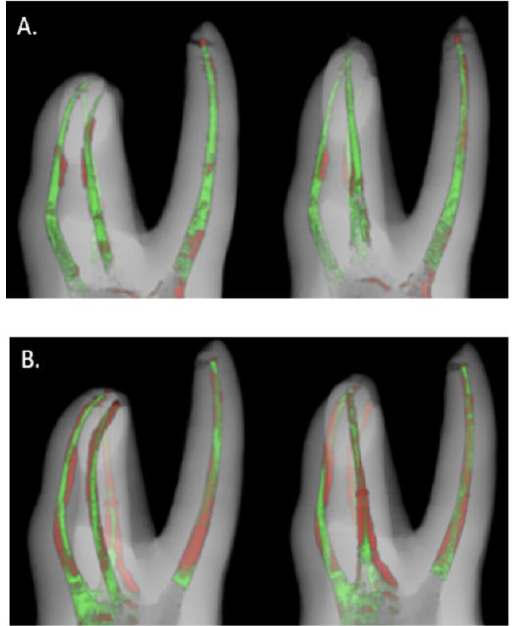
Figure 2. Three-dimensional reconstructed images of the obturated root canals. The green area in- dicates gutta percha and the red area displays sealer. The sample of the SC group showed more red space which means the sealer portion is more extensive than that of the CW group. On the other hand, gutta percha occupied most of the canal space of the CW group. ( A ) Reconstructed micro-CT scan image of CW group ( B ) Reconstructed micro-CT scan image of SC group CW, continuous wave filling; SC, single cone filling. The mean values of %V in the CW and SC groups were 2. 81 ± 1.11% and 1.77 ± 0.82%, respectively, and there was a significant difference ( p < 0.05). Based on the root canals, %V total in the P canal demonstrated a significant difference between the two groups. In the apical area (1 – 4 mm), the %V apical was significantly lower in the SC group in the P canal. In the middle area (4 – 6 mm), the %V middle was significantly lower in the SC group in the MB2 and P canals (Figure 3).